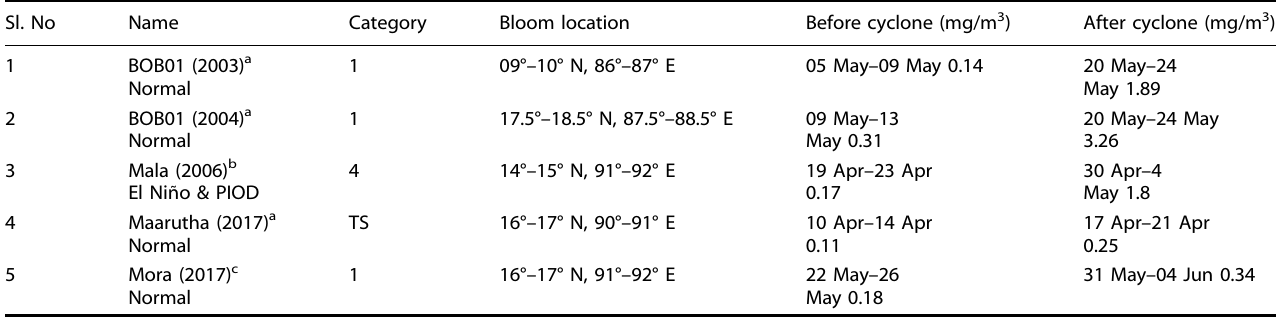
Table 1. The cyclone-induced Chl-a blooms in the pre-monsoon seasons since 1997 in BoB. Sl.